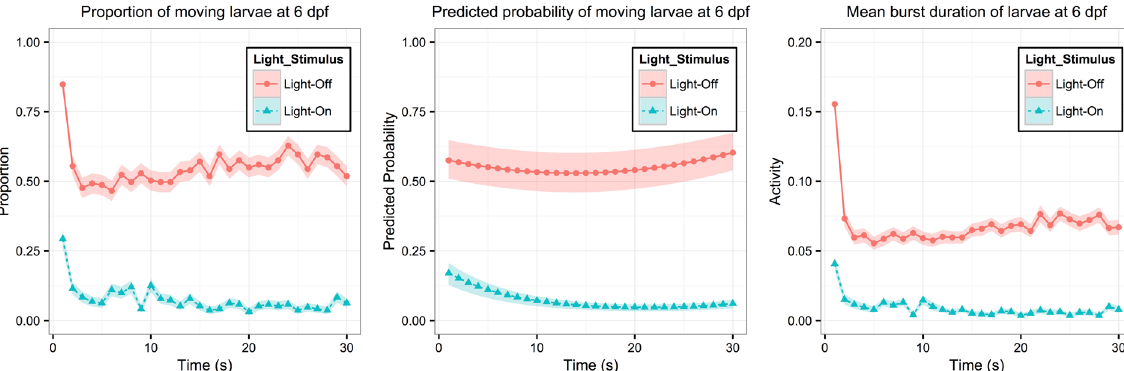
Figure 2. Plots of VMR during the first 30 seconds of the light-stimulus change for AB larvae at 6 dpf. Left panel: Proportions of moving larvae summarized from the data. Y-axis is the proportion of moving larvae and x-axis is time (1–30s). For light onset and offset, the proportions are shown in different colours. The corresponding ribbon represents 1 standard error from the proportion. Middle panel: Predicted probability of moving larvae. Y-axis is the predicted probability of detecting a moving zebrafish larva and x-axis is time (1– 30s). The predicted probability is shown in a different colour for each strain. The corresponding ribbons represent the lower and upper quartiles. Note that the Y-axes of left and middle panels are the proportion and predicted probability of moving larvae respectively, which can be derived from the LOA defined as . Right panel: Mean Burst Duration of zebrafish larvae during the same time interval. For light onset or offset, its corresponding ribbon represents 1 standard error from the mean activity. These data were used for the Hotelling’s T-squared tests showed in Example 2. The sample size in this example is 11460 (Light-On: 5730; Light-Off: 5730).